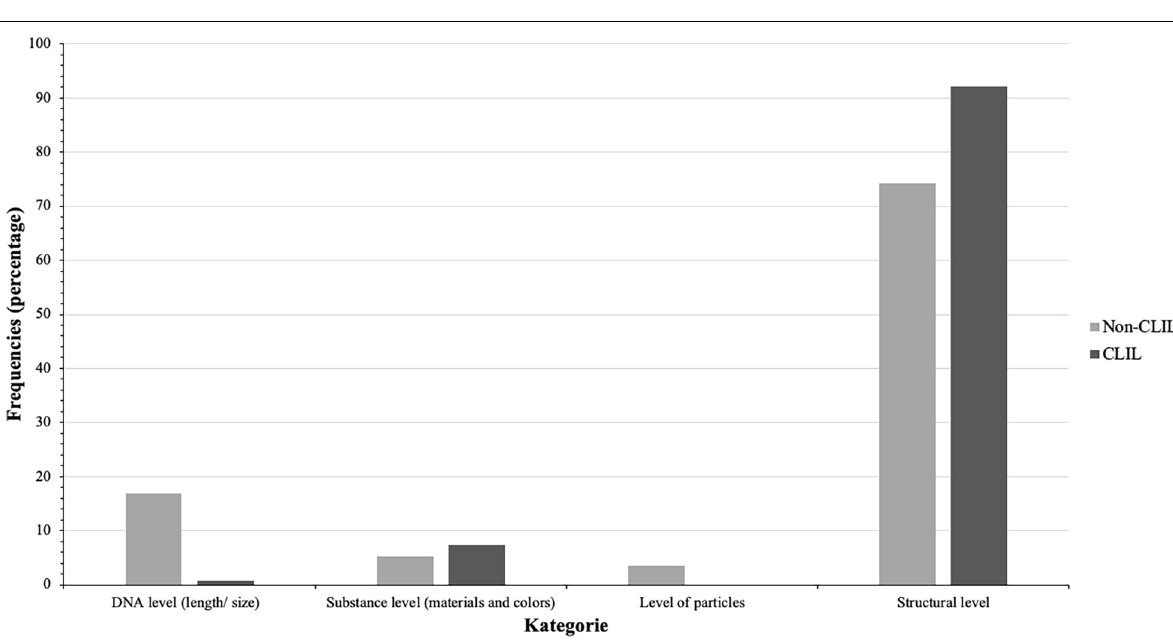
effect size (MWU: Z = –6.574, p < 0.001, r = 0.304;